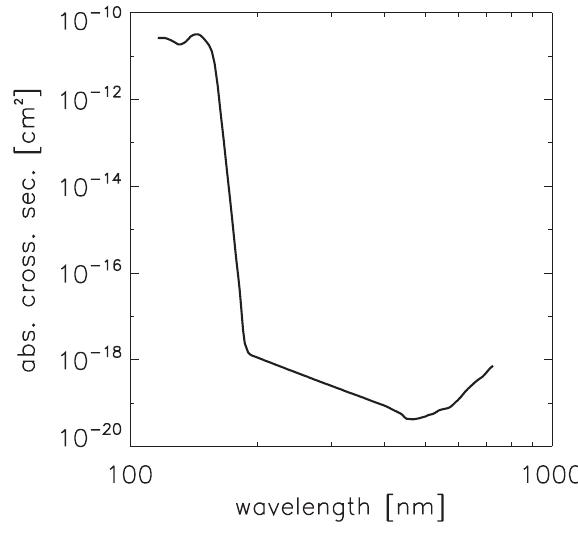
Fig. 6. Absorption cross section as a function of wavelength for ice particles of 30 nm radius using complex refractive indices from Warren